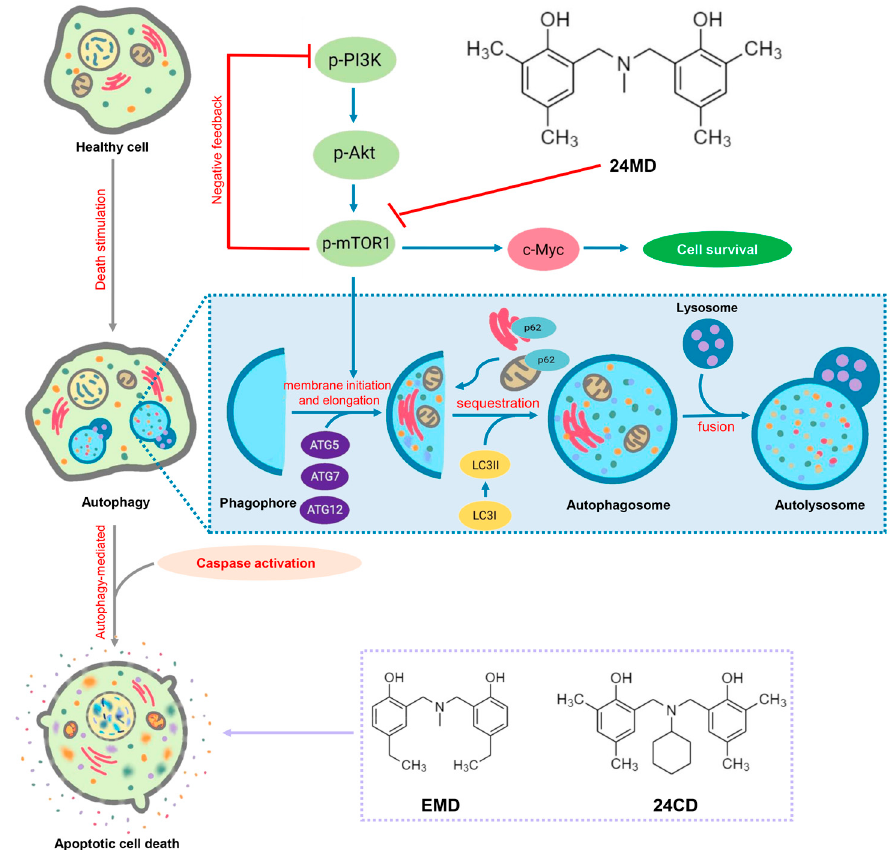
Figure 6. Autophagy is a multi-step catabolic process which controls cellular homeostasis and response to stress stimulation. As mTOR is the main autophagic suppressor, the type I PI3K-Akt-mTOR signaling which plays an important role is inhibited under the autophagic induction. The phagophore is generated, while ATG5-ATG12 associated with ATG7 is activated for vesicle elongation and completion. The other key marker which is involved in this step is LC3. LC3I is transformed to an autophagic-vesicle associated form LC3II. This cleaved form is designated as a marker of autophagy. The vesicle engulfs the cytosolic material which is recruited by a cargo receptor such as SQSTM1/p62. Then, a maturated autophagosome fuses with lysosomes to become autolysosomes. The engulfed material is degraded by acidic hydrolases and lysosomal enzymes. Autophagic-mediated apoptosis cell death is a process in which the autophagic induced apoptosis mechanism through degradation of the anti-apoptotic protein leads to activating the caspase cascade. 24MD could enhance autophagic-mediated apoptosis cell death by inhibiting mTOR signaling. However, the different substituted groups, EMD and 24CD, could only demonstrate the apoptosis inducing activity.